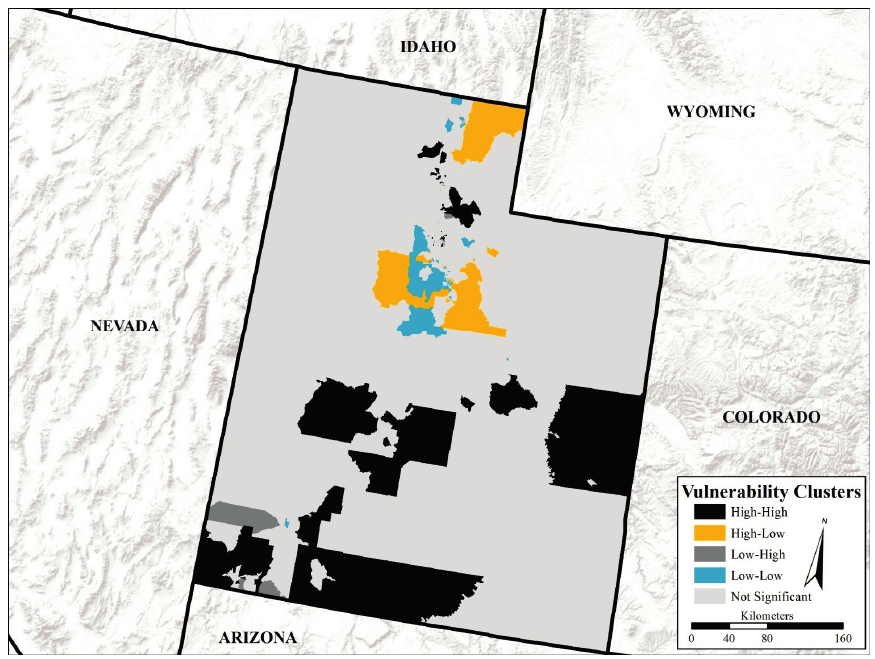
Figure 4. Clustering of vulnerability categories for Utah based on the traditional SoVI using the Local Moran’s I statistic. The pattern demonstrates some areas of clustering near populated